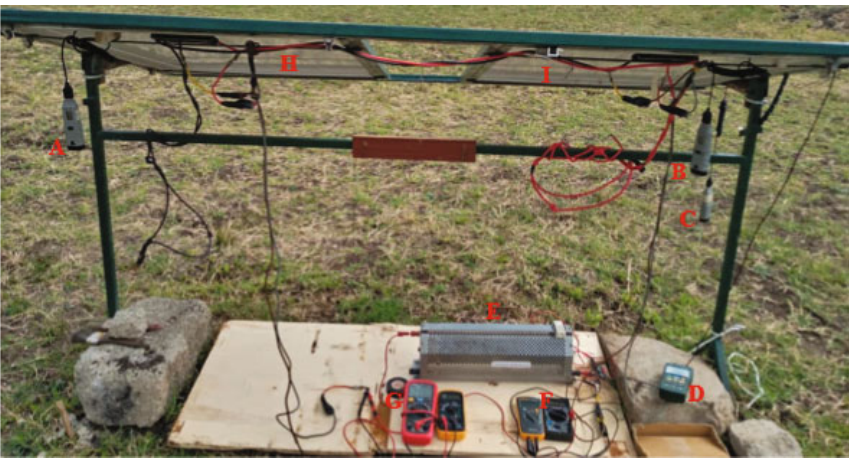
Figure 2: Equipment and accessories: (a – c) data loggers with temperature and humidity sensors; (d) solar meter; (e) rheostat; (f, g) digital multimeters; (h, i) solar panels.